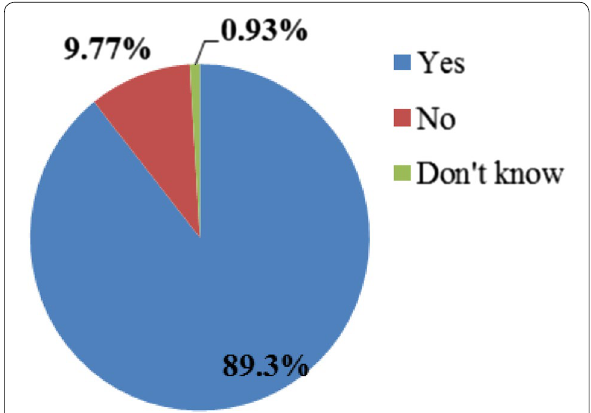
Fig. 5 Economic effects of water pan on crop